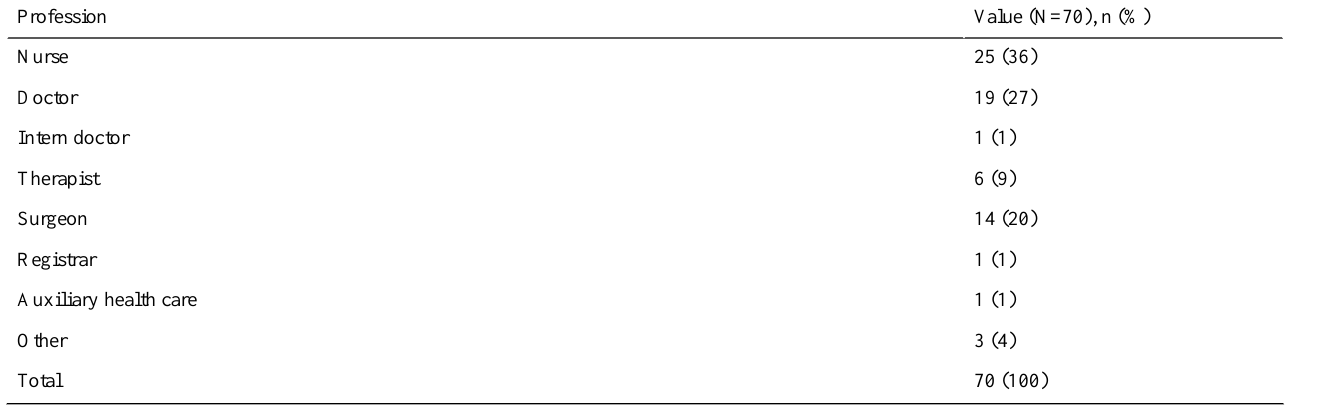
Table 1. Participant